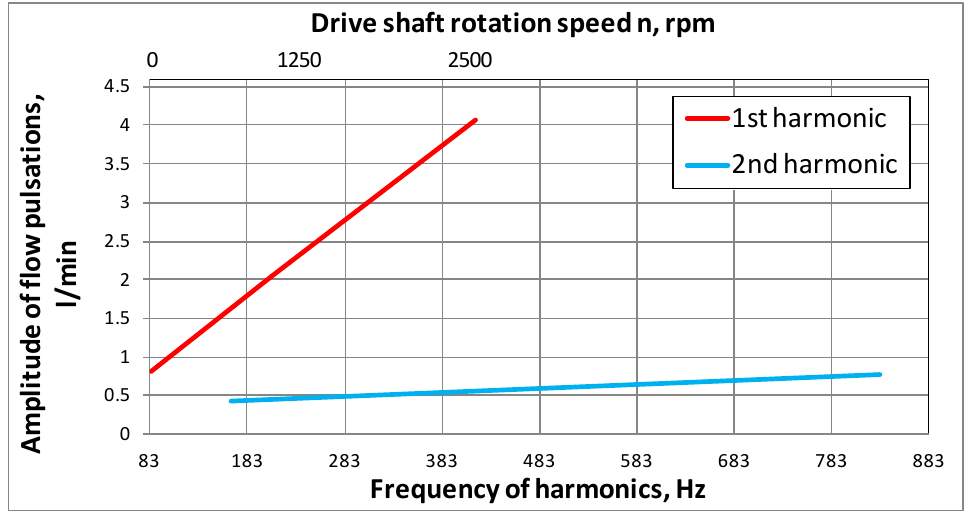
Figure 26. Amplitudes of flow rate pulsations at the pump outlet in an experiment with an “infinitely long” pipeline.